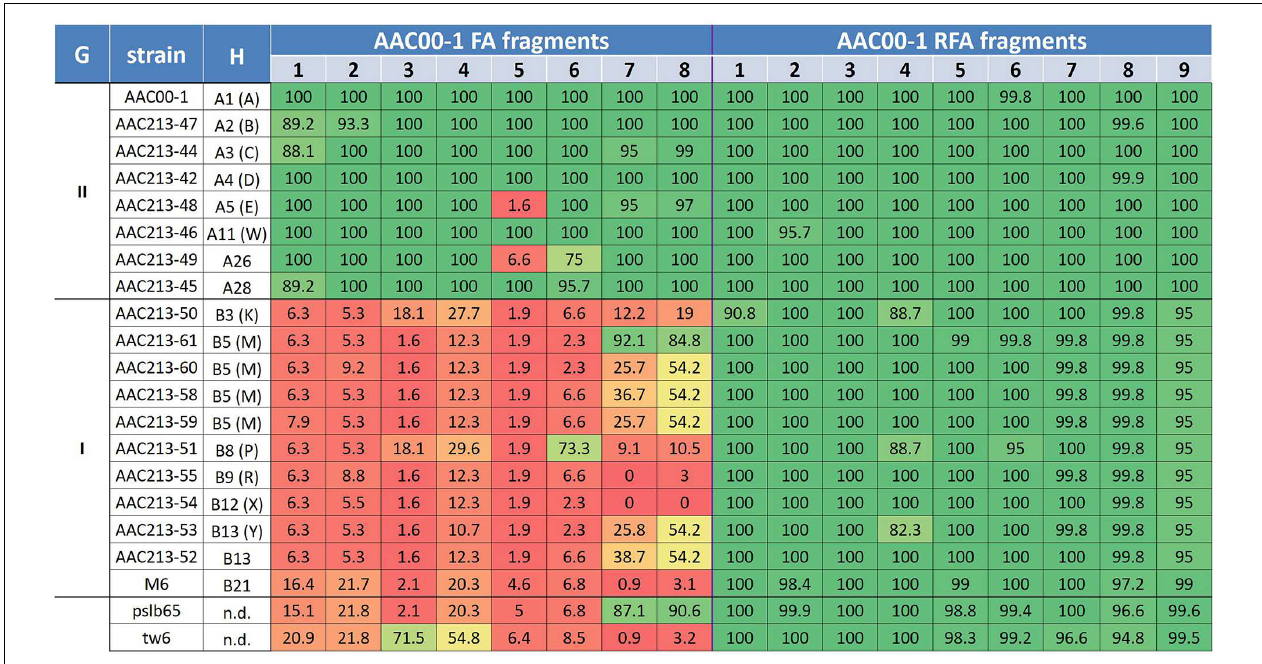
FIGURE 3 | Coverage percentage of Acidovorax citrulli strain AAC00-1 FA fragments 1–8 and RFA fragments 1–9 in the draft genomes of several group I and II A. citrulli strains. The fragments were used as queries in MegaBlast analyses (Geneious 8.1.7) against the strain contigs and the total coverage was calculated. The percentage of coverage is indicated for each fragment/strain. To emphasize the picture, a color scale was used that correlates with the level of coverage. From low to high coverage: dark red, light red, orange, yellow, light green, dark green. G, group; H, Haplotype designation based on PFGE analysis following digestion with SpeI . Where relevant, letters between brackets indicate the old haplotype designation as described in previous publications (Walcott et al., 2000, 2004); n.d., not determined.